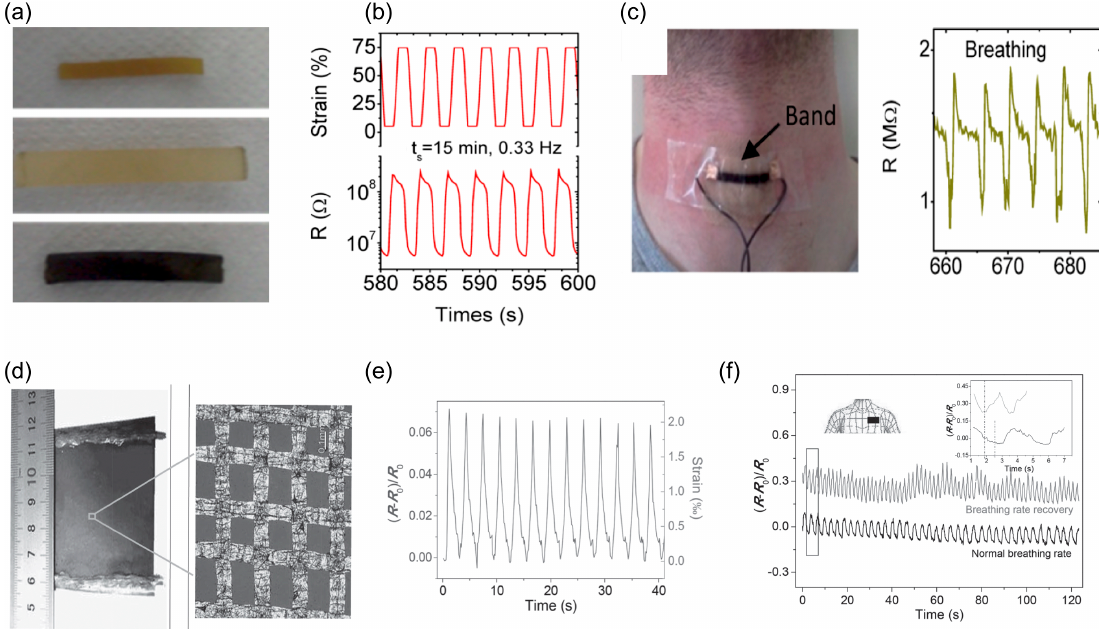
Figure 5. Strain sensors for respiratory monitoring: ( a ) treatment of rubber band to infuse graphene, top to bottom, respectively, show untreated elastic band, elastic band after soaking in toluene for 3.5 h and a graphene-infused band; ( b ) resistance changes of sensors as a response to cyclic strain and release; and ( c ) graphene infused band attached to the throat to monitor respiratory rate (Reprinted with permission [15]. Copyright 2014, American Chemical Society, http://pubs.acs.org/doi/full/10.1021/nn503454h); ( d ) Optical images of graphene woven fabric deposited on PDMS composite film; ( e ) relative resistance changes between 0% and 0.2% strain; and ( f ) schematic picture of placement of the sensor on chest and the respiratory rate detected by it normally and while recovering from exercise (Reprinted with permission [16]. Copyright 2014, John Wiley and Sons).